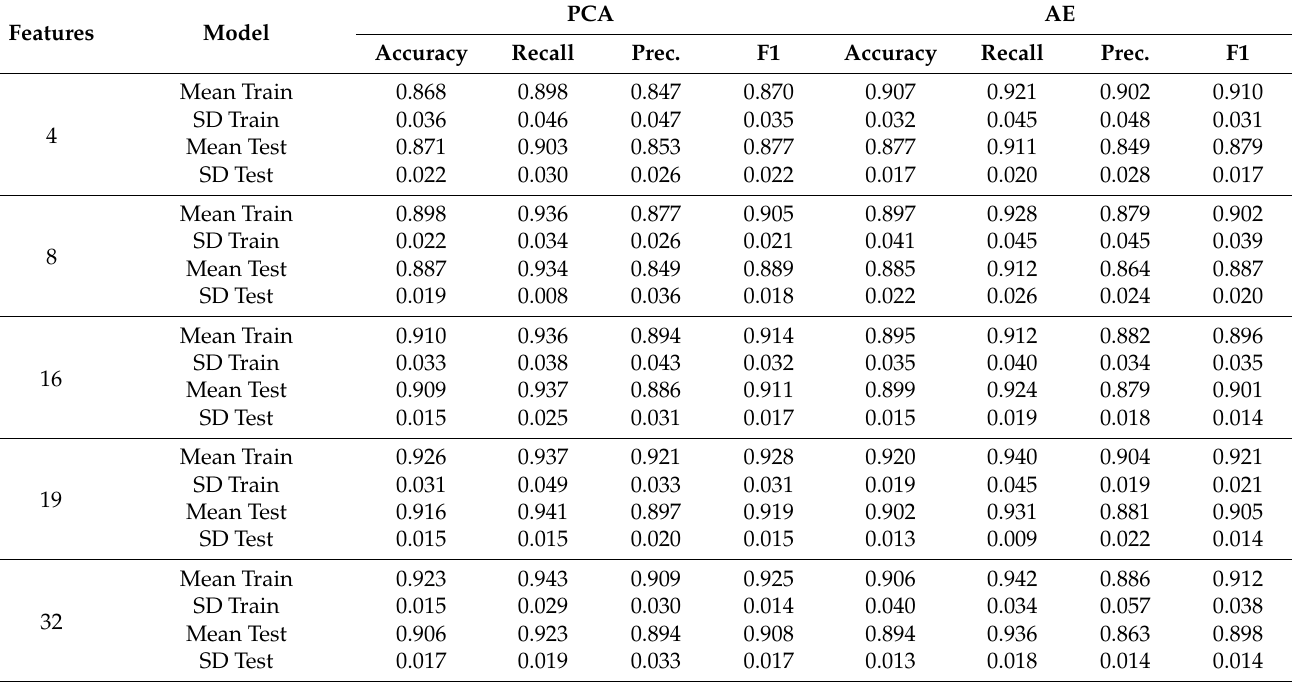
Table A1. Binary classification metrics for RF per number of PCs and AE latent space